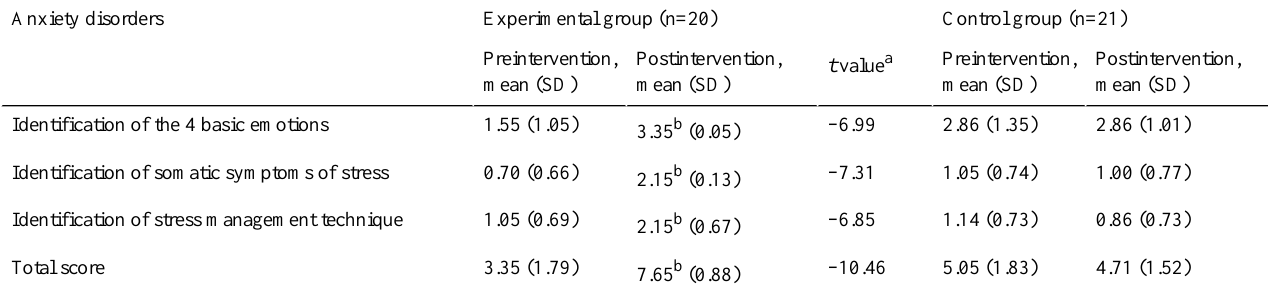
Table 5. Identification of basic emotions, somatic stress symptoms, and stress management techniques before and after the intervention for the experimental and control groups.